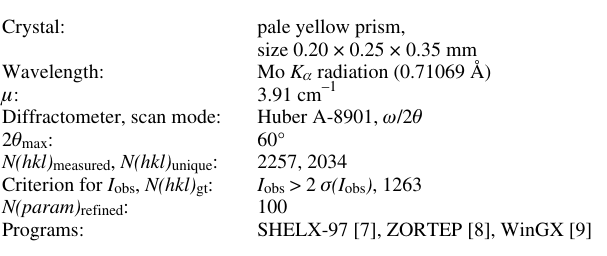
Table 1. Data collection and handling.